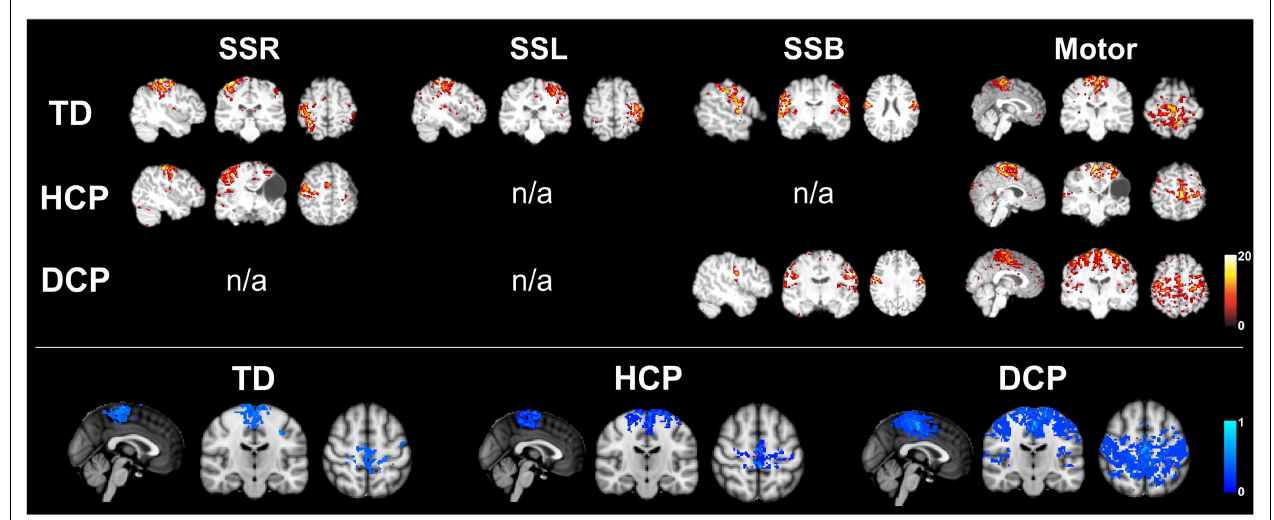
FIGURE 6 | Upper panel: RSNs for the same participants as in Figure 1 (TD2, HCP1, and DCP3 children) . SSR, right somatosensory RSN; SSL, left somatosensory RSN; SSB, bilateral somatosensory RSN; motor, motor RSN ( z -scores). Lower panel: mean motor RSN (lower panel) for the three groups of